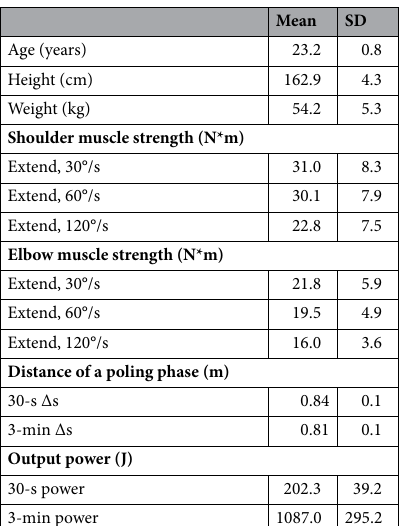
Table 1. Demographics, strength, and output power measures (n = 19). SD standard deviation, ∆ s distance of a poling phase during double poling.